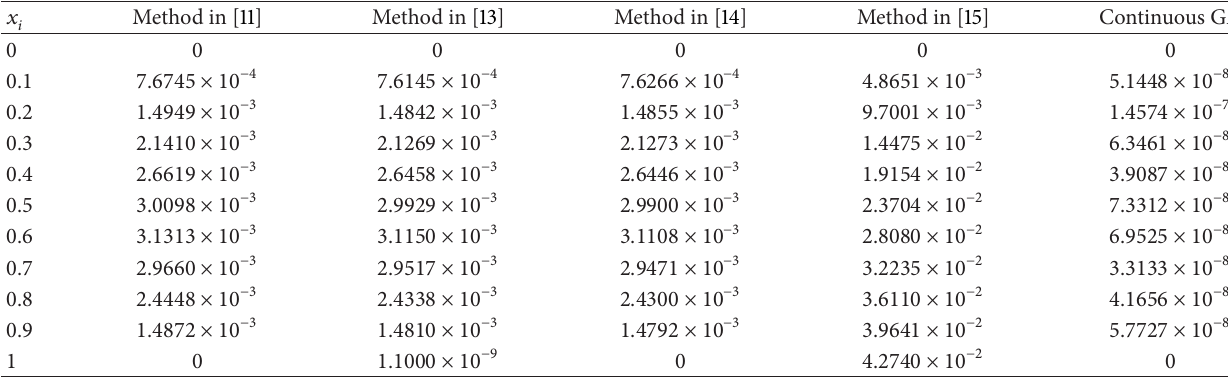
Table 5: Absolute error results for Troesch’s problem when 𝜆 = 0.5